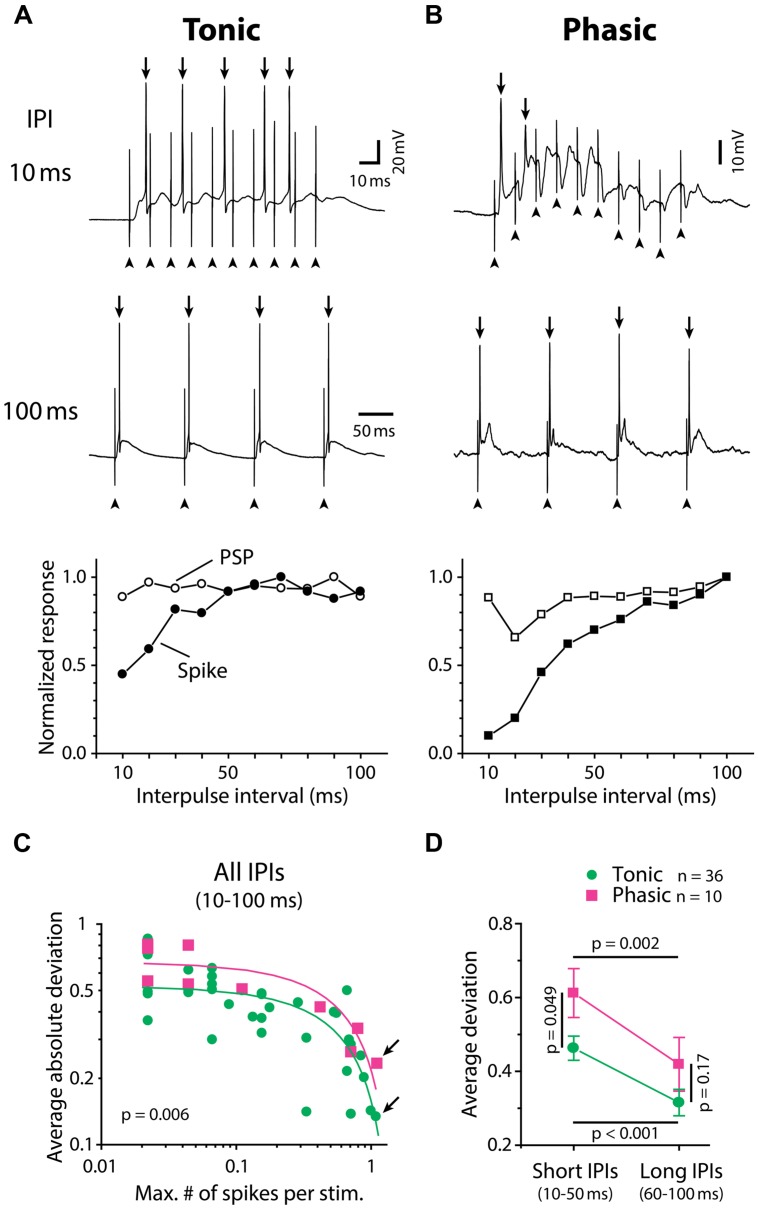
Tonic neurons convert IPI tuning of synaptic inputs into spike output with higher fidelity than phasic neurons. (A,B) Synaptically evoked spiking responses of a tonic neuron (A) and a phasic neuron (B) to ELa stimulation with 10 (top) and 100 (middle) ms IPIs. In these examples, both neurons fired action potentials (arrow) in response to every stimulus at 100 ms IPI. However, at 10 ms IPI, the phasic neuron rapidly adapted to stop firing after one full-size and one attenuated action potential out of ten stimuli while the tonic neuron still exhibited five full-size action potentials. Arrowhead, stimulus artifact. Horizontal scale bars refer to both (A) and (B). Bottom, IPI tuning curves obtained from the same cells, which were plotted for average number of action potentials (filled symbols; spike) and average maximum depolarization (open symbols; PSP). Both tuning curves were normalized by dividing by the maximum response across intervals. To generate PSP tuning curves, the raw membrane potential trace containing action potentials was median-filtered to remove high-frequency components due to spikes and estimate the underlying synaptic potentials (see Materials and Methods for details). (C,D) Spike tuning curves of tonic neurons (green circle) are more similar to their PSP tuning curves compared to phasic neurons (magenta square). The deviation between spike and PSP tuning, defined as normalized PSP response minus normalized spike response at the same IPI, was plotted in two different ways in (C) and (D). Legend in (D) also applies to (C). (C) In both tonic and phasic neurons, the average of absolute values of the deviation across all IPIs (10–100 ms) was negatively correlated with the maximum number of spikes across IPIs (abscissa: divided by the number of stimulation, or average number of spikes at best IPI; r < –0.7, p < 0.01; green and magenta lines represent linear regression lines for tonic and phasic neurons, respectively). Regardless of how many action potentials the recorded neuron fired during the stimulus train, the average absolute deviation was consistently smaller in tonic neurons than in phasic neurons (ANCOVA; p = 0.006). This suggests that, during the process of converting synaptic inputs into spike output, IPI tuning curves are less distorted in tonic neurons than in phasic neurons throughout a range of synaptic activation. Arrows indicate data obtained from (A) and (B). (D) Average of actual deviation, not absolute value, at short (10–50 ms) IPIs was larger than that at long IPIs (60–100 ms) in both tonic and phasic neurons. Because positive deviation reflects a spiking response that is suppressed relative to the synaptic response, this result indicates low-pass filtering of PSP tuning into spike tuning in both tonic and phasic neurons. Compared to tonic neurons, the deviation of phasic neurons was larger at short IPIs but not at long IPIs, suggesting that the low-pass filtering effect is more prominent in phasic neurons. Multiple comparison analysis was performed by the Holm–Sidak post hoc method following two-way repeated measures ANOVA. Black line indicates the pair of comparison and corresponding p value.